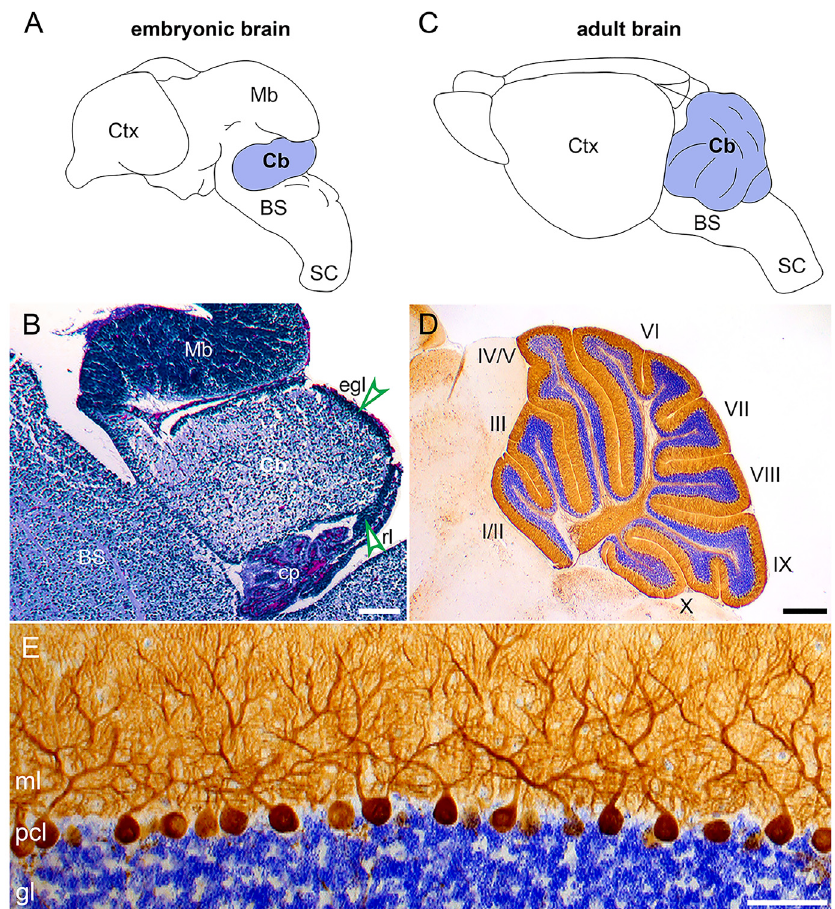
Figure 3. Development of the cerebellar cortical layers. ( A ) A schematic depicting the embryonic brain with the cerebellum highlighted in color. ( B ) A sagittal section from an embryonic day 16 brain with the cell bodies of neurons labeled using a Nissl stain (violet). The densely labeled external granular layer (green arrowhead, egl) and rhombic lip (green arrowhead, rl) are visible. ( C ) A schematic depicting the adult brain with the cerebellum highlighted in color. ( D ) A sagittal section from an adult brain with the cell bodies of neurons labeled using a Nissl stain (violet) and Purkinje cells labeled using calbindin immunohistochemistry (brown). The densely labeled granule cells are visible in the innermost layer of the cerebellar cortex, and the Purkinje cell somas and dendrites are visible in the outer layers of the cerebellar cortex. Roman numerals identify the 10 lobules. ( E ) A magnified view of ( D ). Scale bars = ( B ) 100 μm, ( D ) 500 μm, and ( E ) 50 μm. BS, brainstem; Cb, cerebellum; cp, choroid plexus; Ctx, cerebral cortex; gl, granular layer; Mb, midbrain; ml, molecular layer; pcl, Purkinje cell layer; SC, spinal